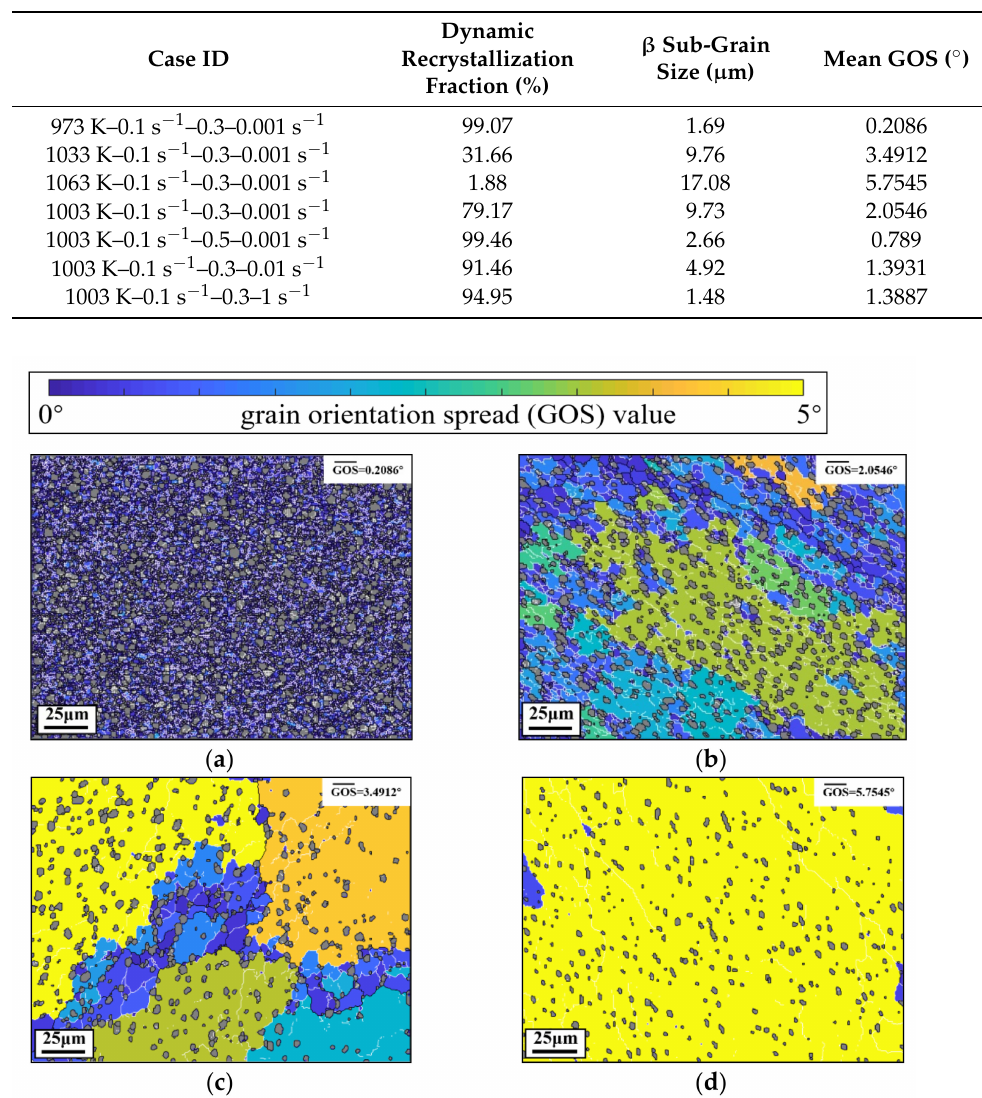
Table 3. The dynamic recrystallization fraction and average sub-grain size of β phases.